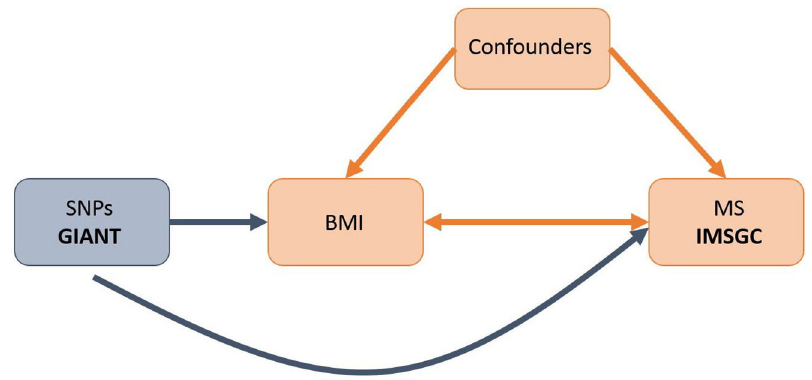
Fig 1. Schematic representation of an MR analysis. This diagram shows that SNPs associated with BMI were selected from the GIANT consortium. Corresponding effect estimates for these SNPs upon risk of MS were obtained from the IMSGC. Because of the randomization of alleles at meiosis, SNPs are not associated with confounding variables that may bias estimates obtained from observational studies.